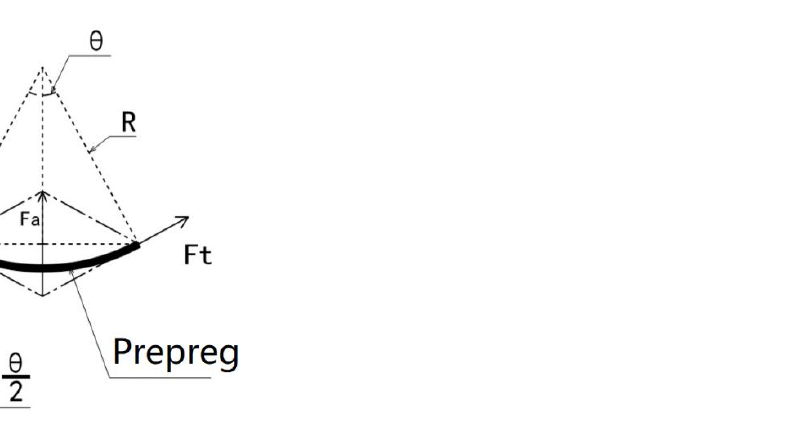
Figure 2. Delamination mechanism of prepreg on the concave surface.